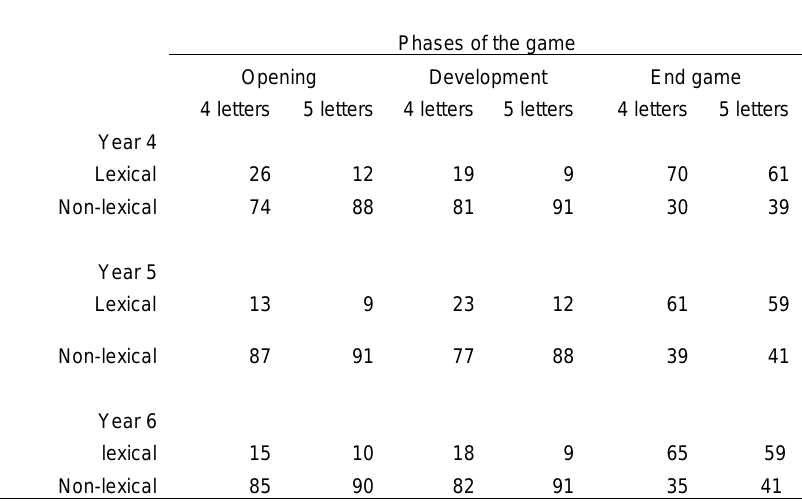
Phases of the game Opening